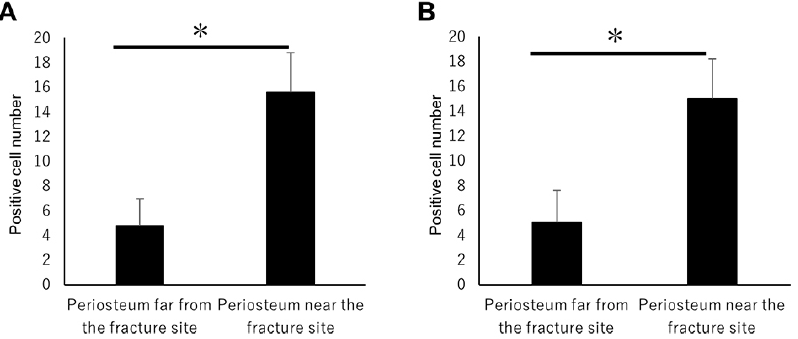
Figure 3. The positive cell number count on day 1. ( A ) Runx2-positive and ( B ) Osx-positive cell numbers in the periosteum near the fracture site were remarkably higher than those far from the fracture site. Data represent the mean ± SE (n = 3/group). Asterisks indicate the statistical significance of the differences (* p < 0.05, t -test).